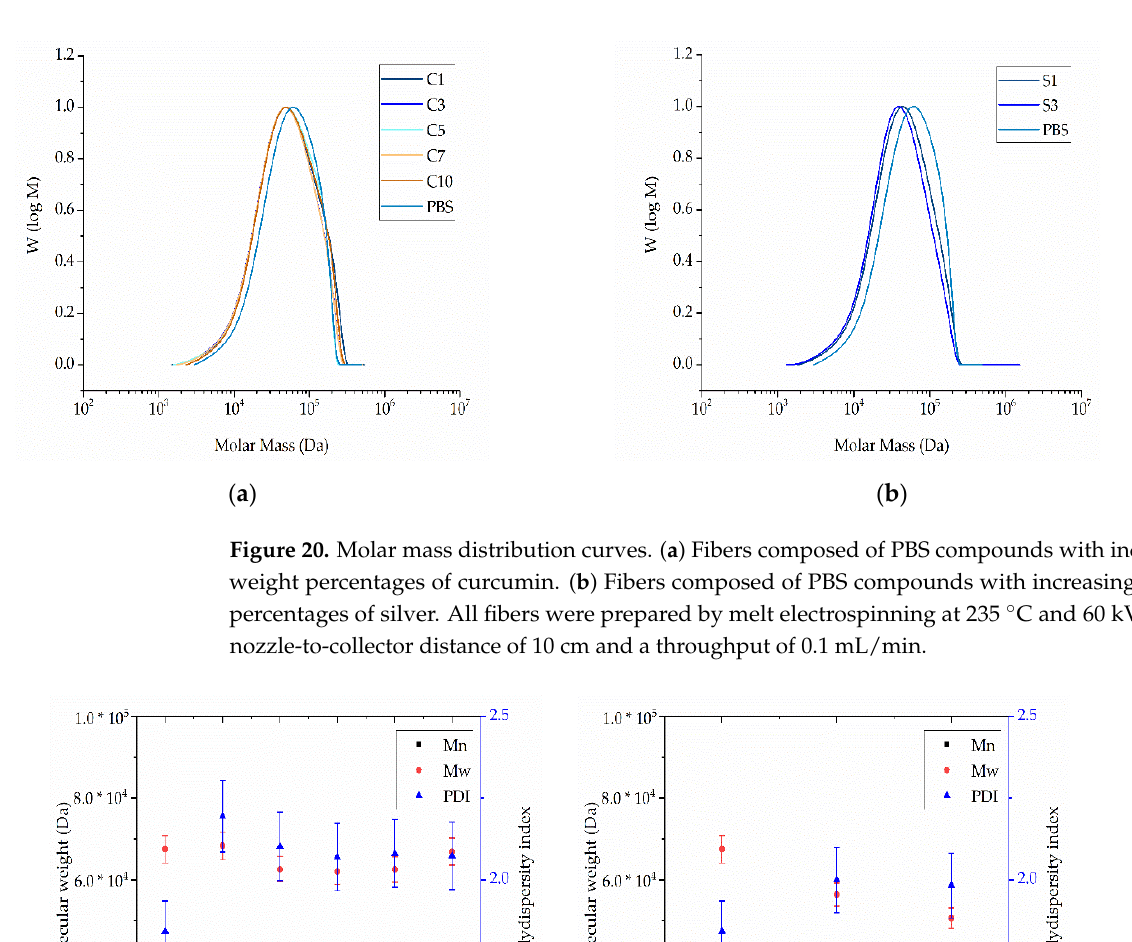
Figure 21. Weight average relative molecular weight (Mw), number average molar mass (Mn) and polydispersity index (PDI) of ( a ) PBS-curcumin compound fibers and ( b ) PBS-silver compound fi- bers. Data are means ± standard deviations ( n = 3).